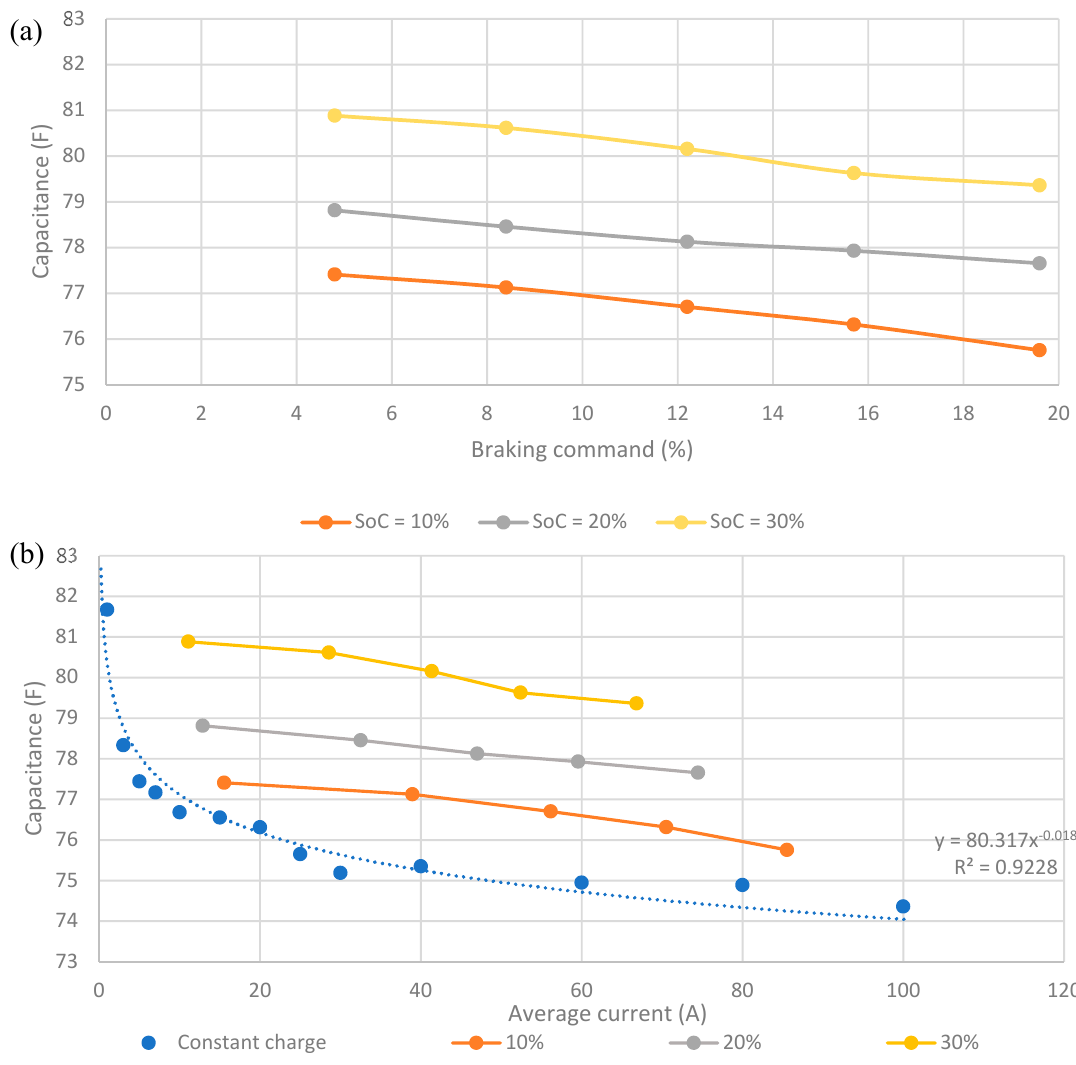
Figure 7. ( a ) SC capacitance for different brake commands and initial SoC ( b ) compared to constant current charging.